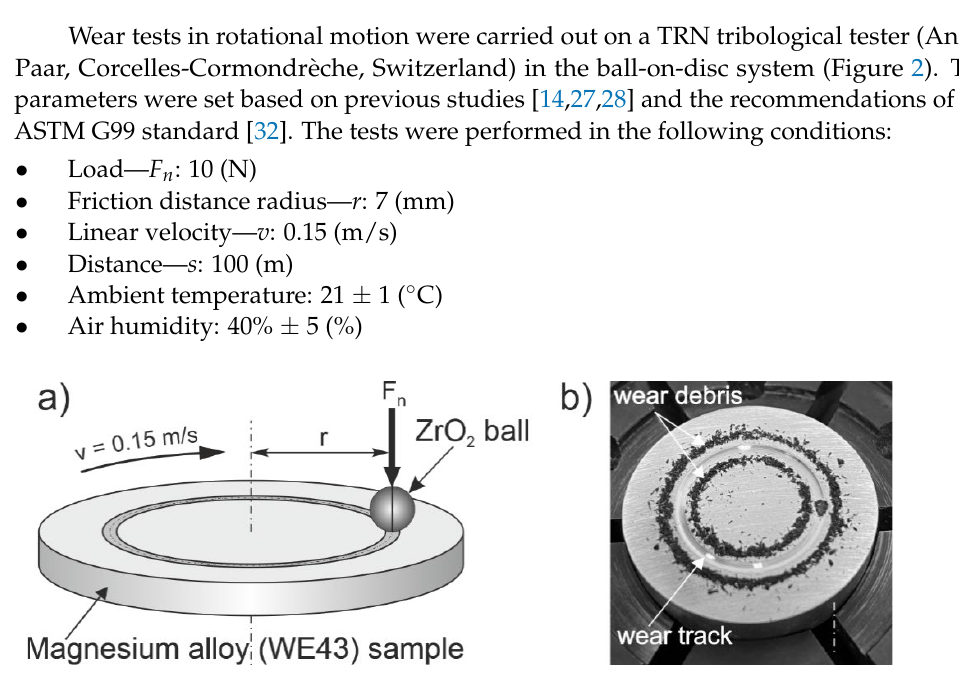
Figure 2. Diagram of a tribological couple ( a ) ; example of a WE43 magnesium alloy sample in its initial state after tribological test ( b ).